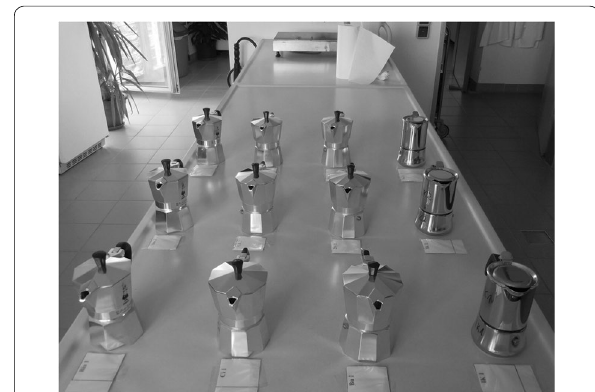
Fig. 1 The moka pots tested were made of aluminum or stainless steel ( Stainless steel The right-hand